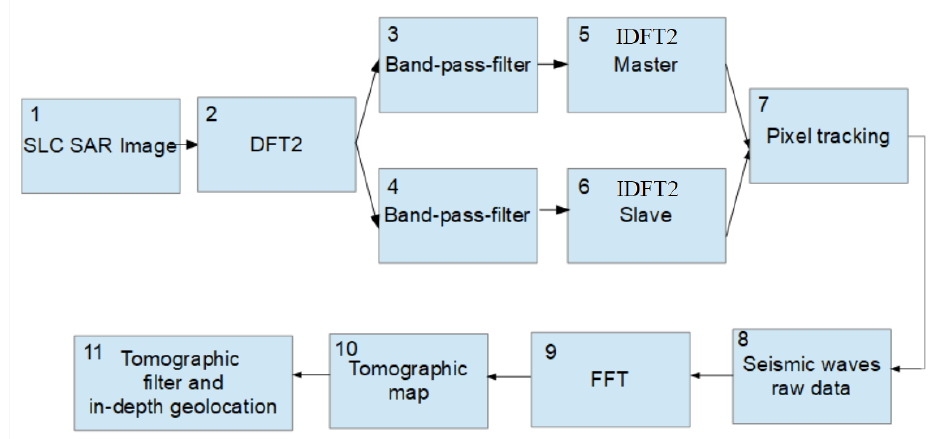
Figure 4. Computational scheme of tomographic